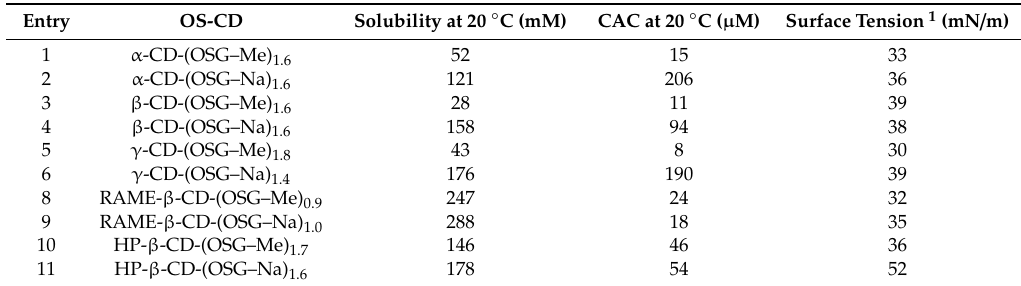
Table 1. Physicochemical properties of